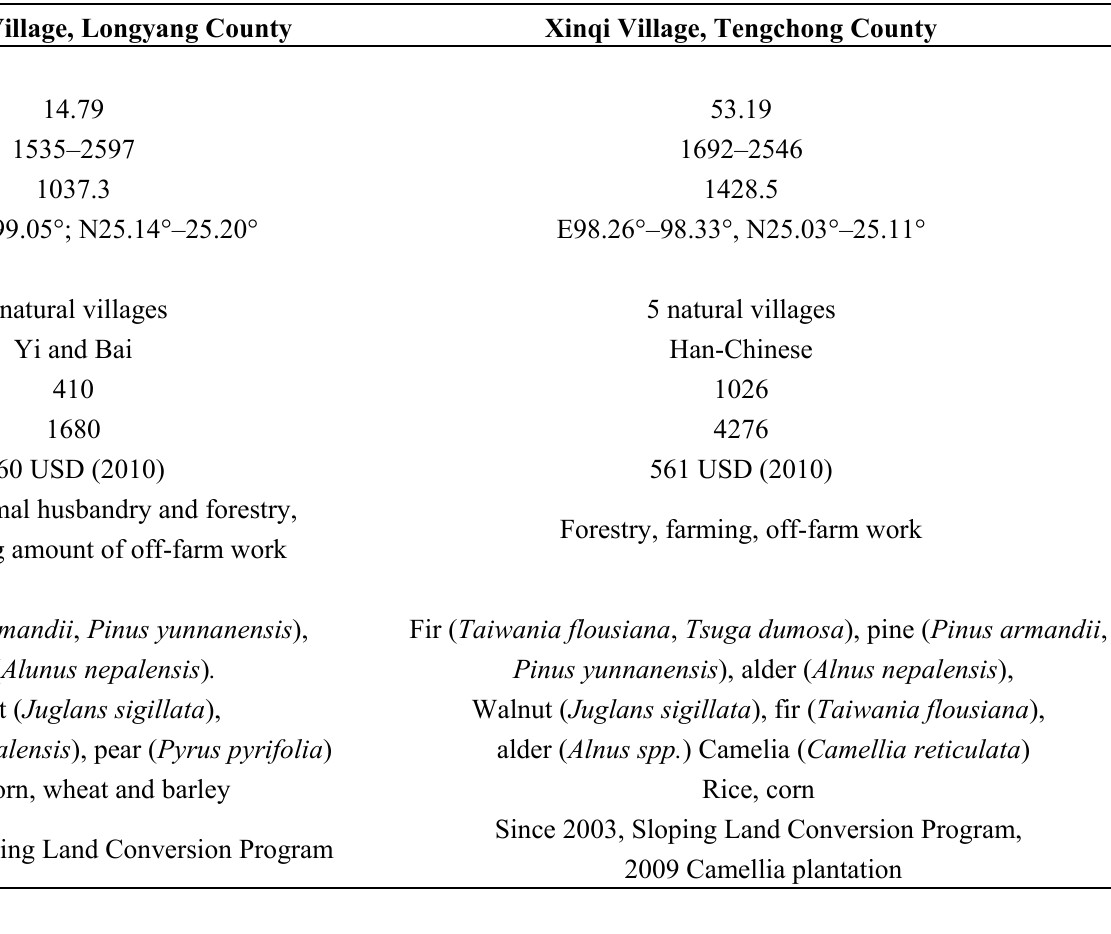
Table 1. Biophysical characteristics and socio-cultural features of the two study